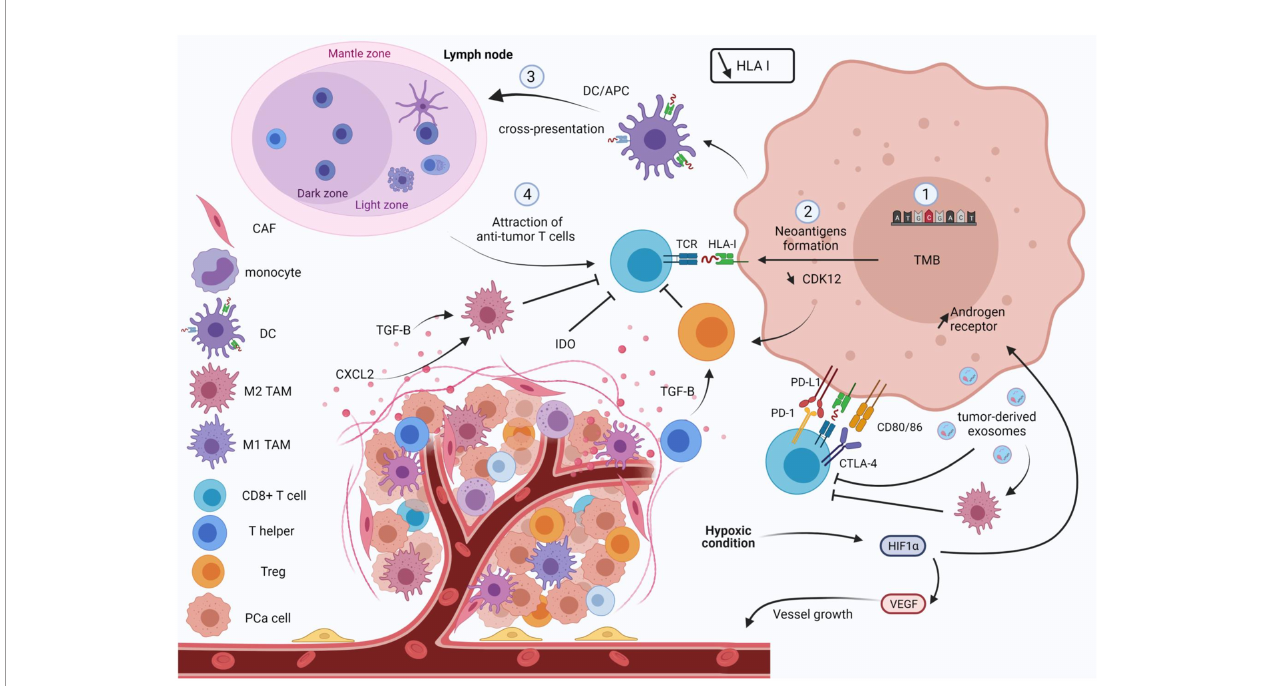
FIGURE 1 | Overview of the physiopathology of prostate cancer. A prostate tumor favors immune escape. Tumor cells harbor a low tumor mutational burden (TMB) and HLA I expression is lost, which decreases the anti-tumor response. Tumor cells also express immune checkpoint inhibitors (PD-L1) such as effector T cells (PD-1 and CTLA-4), leading to exhaustion of cytotoxic T cells. Promotion of immunosuppressive cells such as M2 tumor-associated macrophages or T reg, and suppression of effector T cell activity, are induced by immunosuppressive factors (IDO, CXCL2 and TGF b ). In lymph nodes, expression of PD-L1/L2 by MDSCs establishes a pre-metastatic niche that impairs proliferation of CD8+ T cells. Tumor-derived exosomes are also involved in this immunosuppressive environment by promoting M2 polarization and suppression of CD8+ T cells. Hypoxia molecule HIF-1 is also overexpressed. This induces the expression of the androgen receptor promoting tumor cell growth, notably through remodeling the vasculature. HLA I, human leukocyte antigen; CAF, cancer associated fi broblast; DC, dendritic cell; TAM, tumor-associated macrophage; PCa, prostate